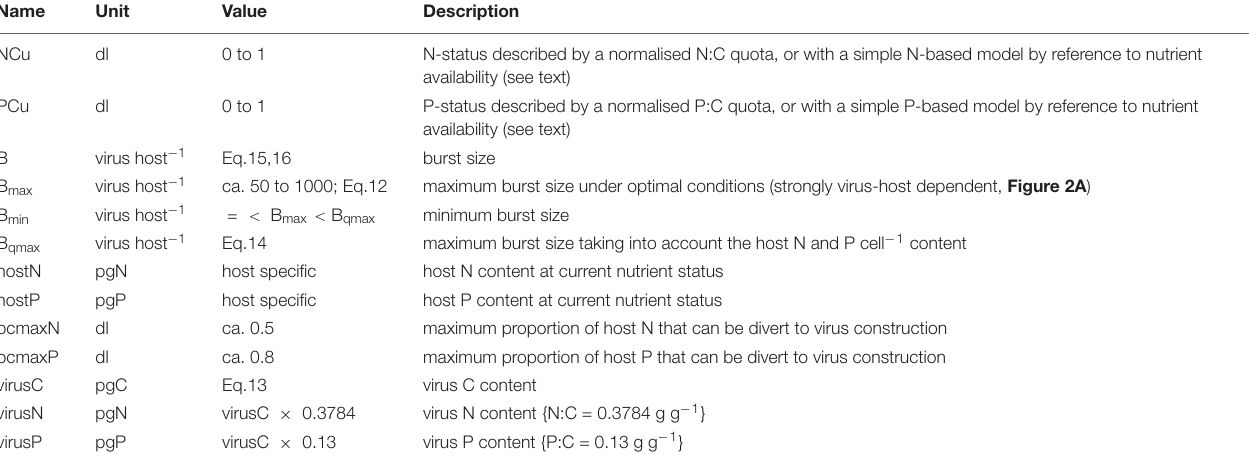
TABLE 3 | Parameters describing the burst